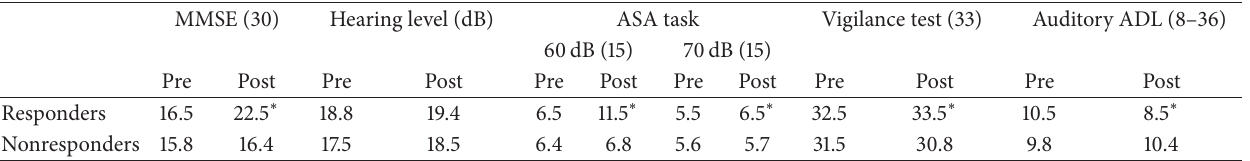
Table 2: Changes after donepezil